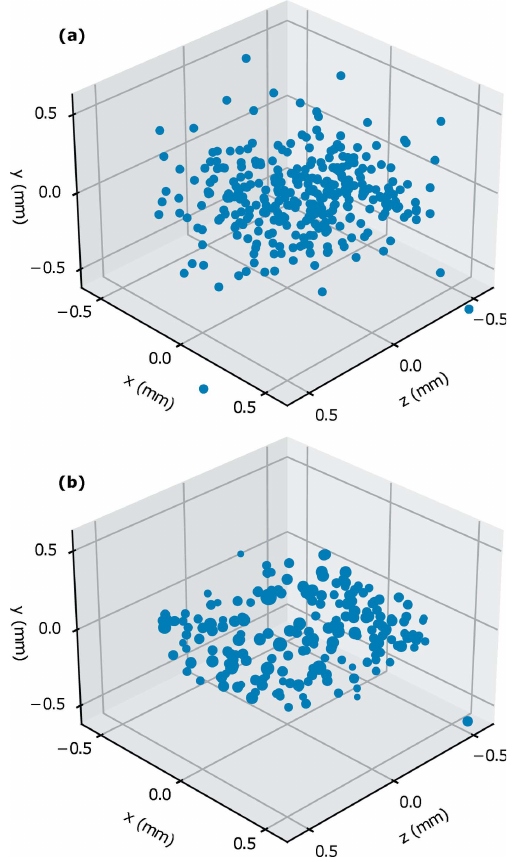
Figure 5 Grain centre-of-mass map of one letterbox scan, ( a ) with poor choices for GrainSpotter parameters, ( b ) after iterative GrainSpotter parameter refinement.